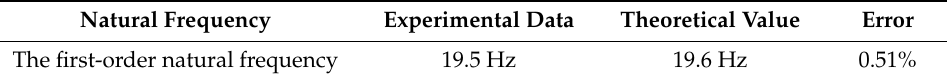
Table 4. Comparison between experimental data and theoretical value.